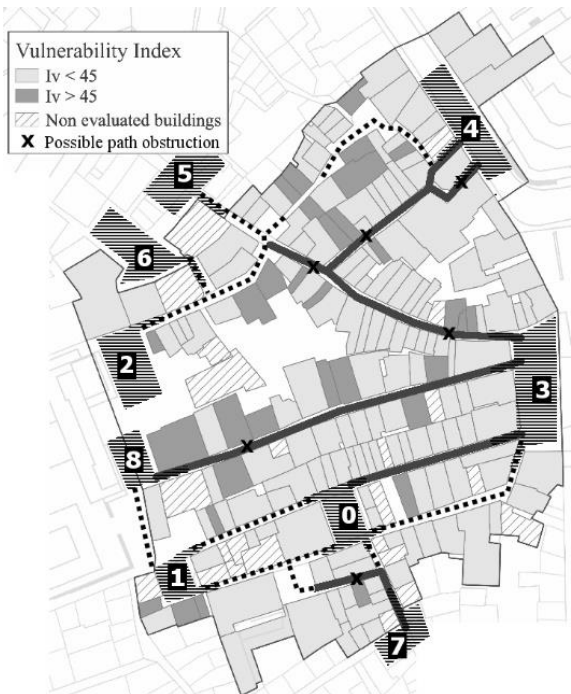
Figure 4. Debris state along the paths (dashed line: Apath free-of- debris >50%; full grey lines: Apath free-of-debris <50%) and possible path obstruction due to